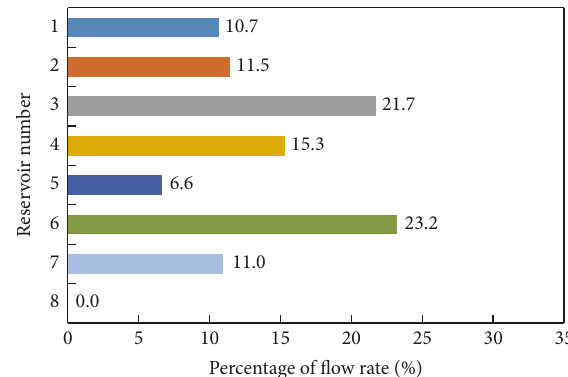
Figure 1: Flow-rate distribution among the reservoirs for the base case of the Shenhua CCS